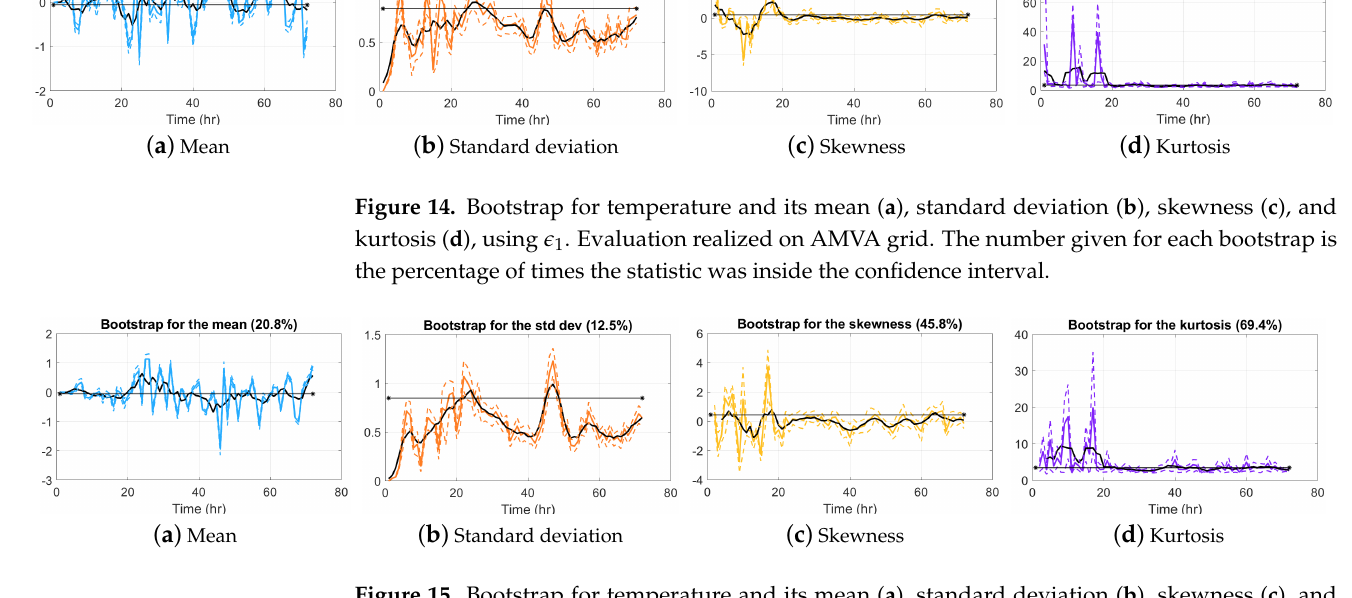
Figure 15. Bootstrap for temperature and its mean ( a ), standard deviation ( b ), skewness ( c ), and kurtosis ( d ), using (cid:101) 1 . Evaluation realized on Barbosa grid. The number given for each bootstrap is the percentage of times the statistic is inside the confidence interval.